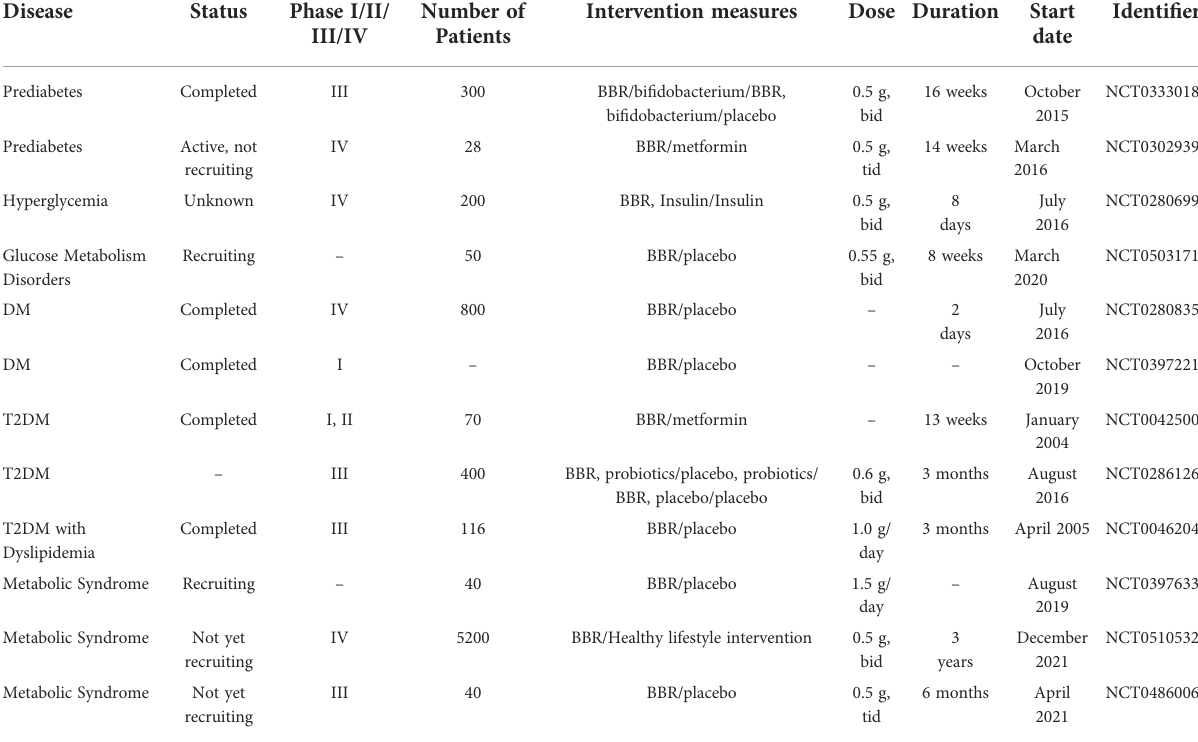
TABLE 1 Clinical trials of BBR registered at ClinicalTrials.gov in the treatment of glucose metabolic disorder. Disease